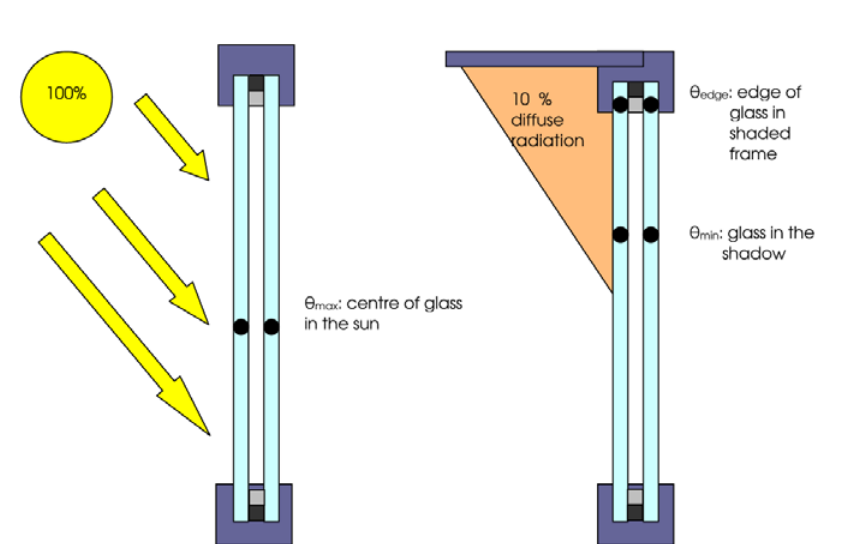
Fig. 2: Description of glazing temperatures considered (left side: centre of glass in the sun, right side: glass and frame in the shade). If a blind is present, the calculations are carried out for both the “blind up” and the “blind down” scenario. The zones with/without sun and with/without blind are both taken into account. Then the maximal temperature difference is determined. A similar procedure is used for sliding doors, partly